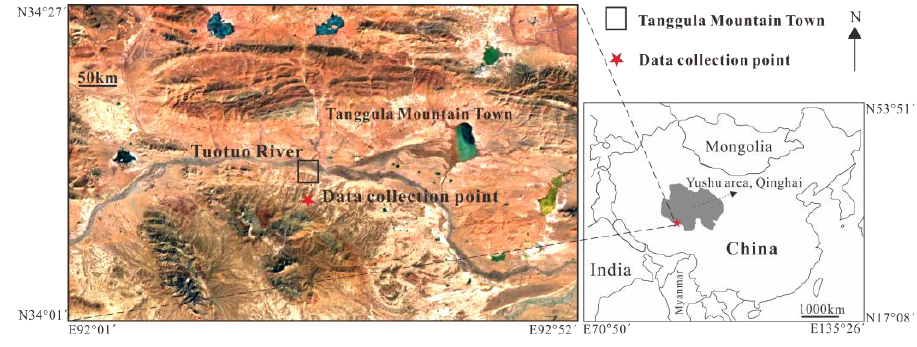
Figure 1. Location map of test site.